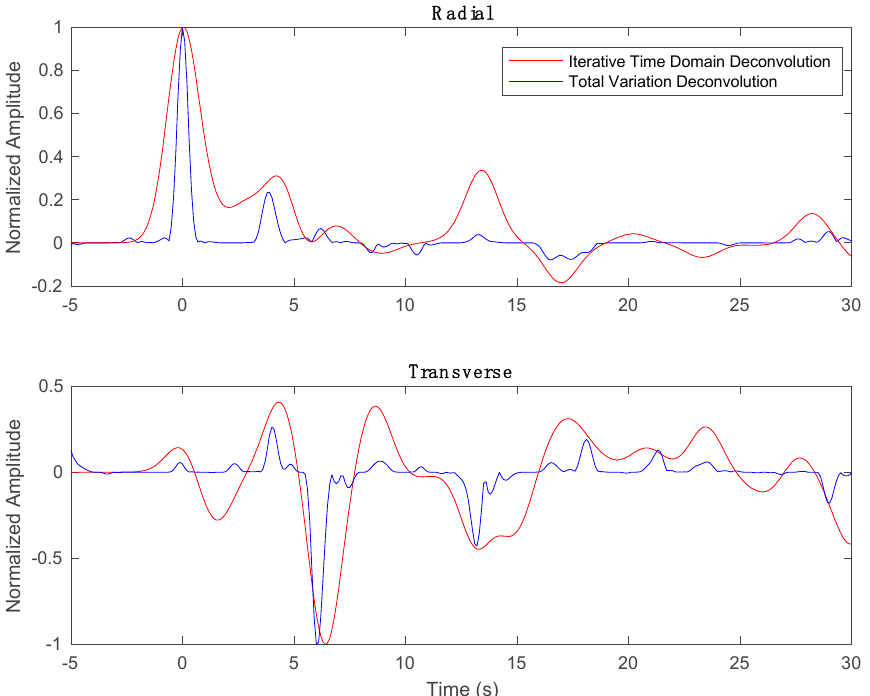
Figure A1. Radial and Transverse components of receiver functions generated with a time domain iterative deconvolution (red) and a time-domain total variation deconvolution (blue).